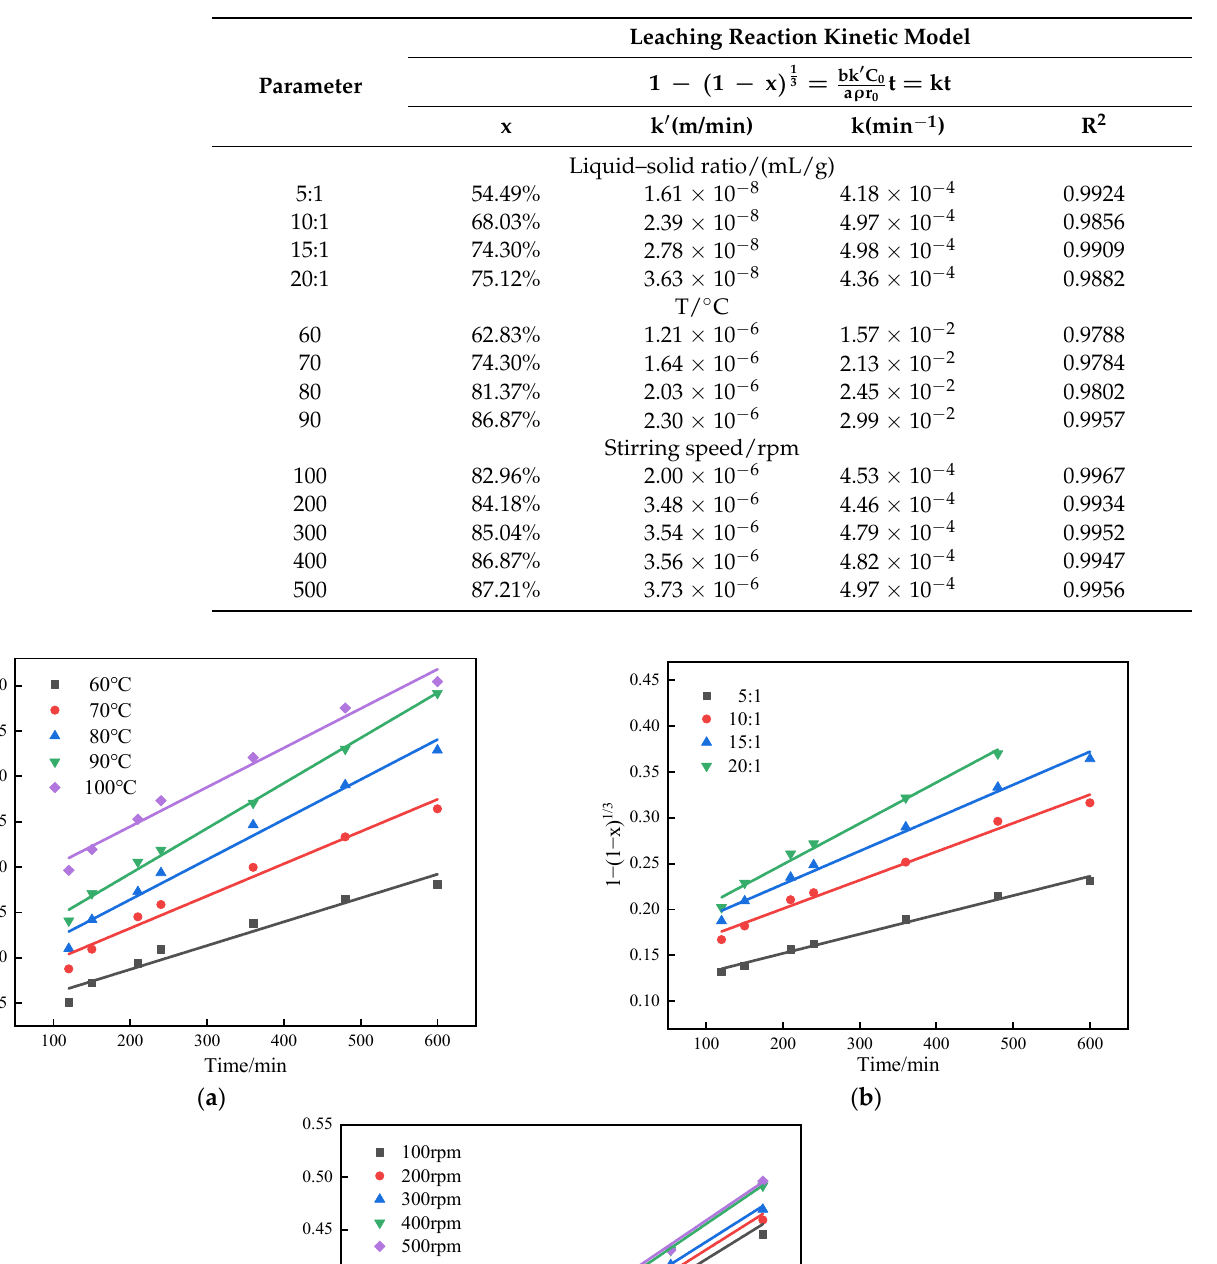
Table 7. Kinetic constants and correlation coefficients of reaction kinetic models under different conditions.